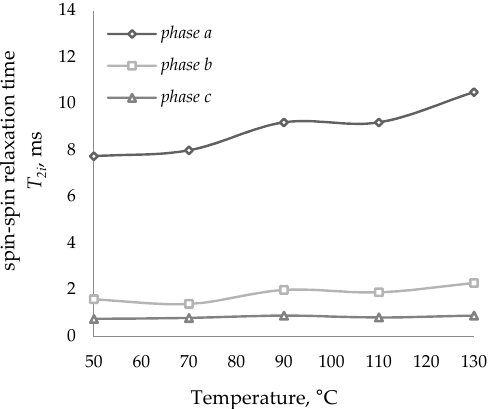
Figure 3. Spin–spin relaxation time T 2 i of bitumen vs. temperature.